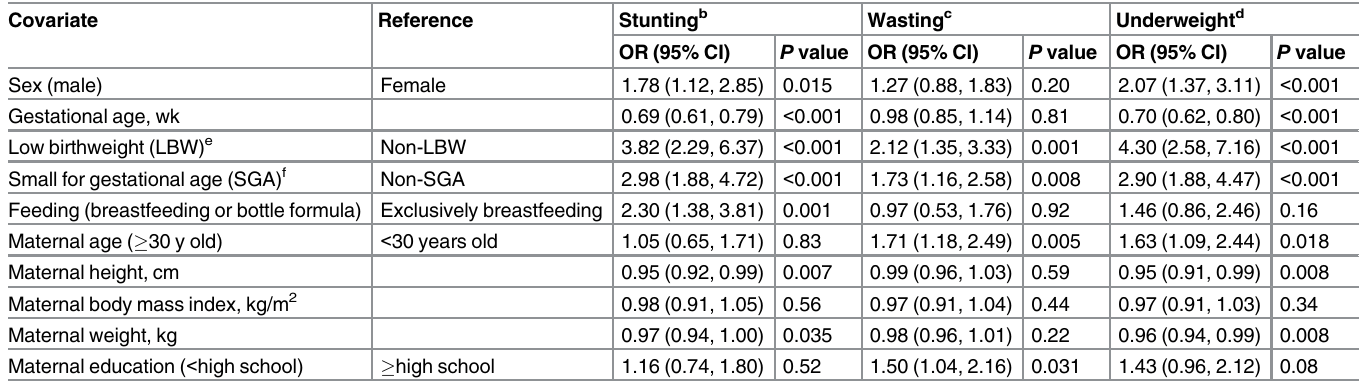
Table 2. Univariable generalized estimating equations models predicting stunting, wasting and underweight at three time points during infancy a .